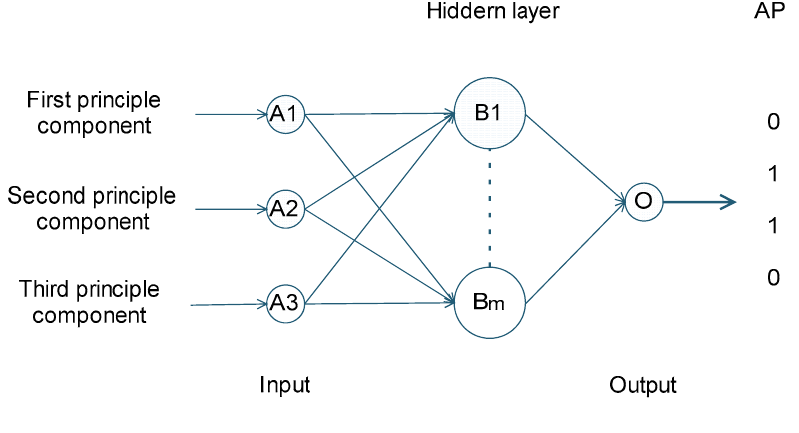
Figure 4. BP-ANNs model.